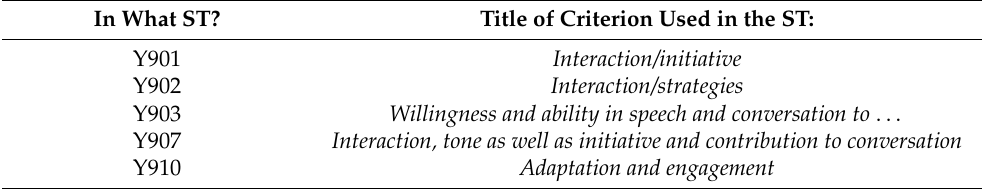
Table 6. Occurrence of Engagement/Initiative and/or Interaction/Interact as C RITERION in the STs for